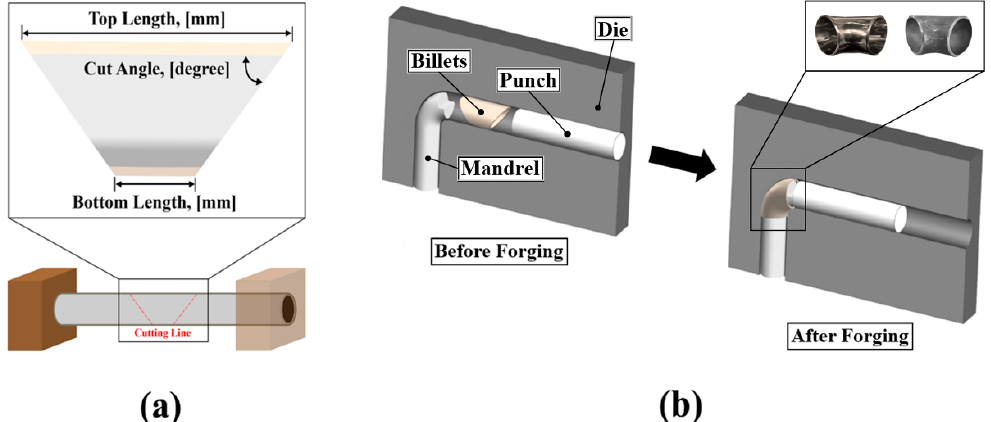
Figure 2. Schematic illustration of the CFJ process: ( a ) cutting process; ( b ) forging–bending